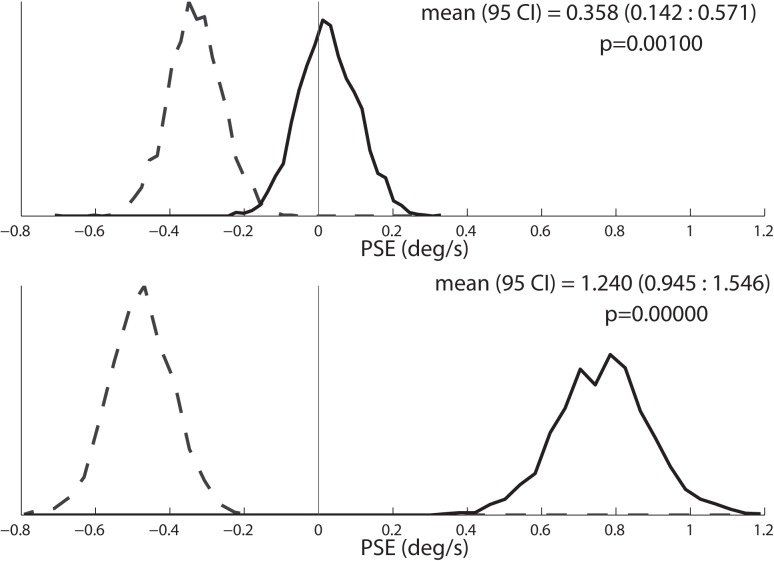
Histogram comparing combined controls and migraineurs response at 8s using a random resampling of responses.Responses from all subjects were included. Responses collected with counterclockwise VFM are represented with a dashed line, clockwise VFM responses are represented with a solid line. The area under the curve in both plots represents the total number of fits (2,000), no specific units are given for the y axis.